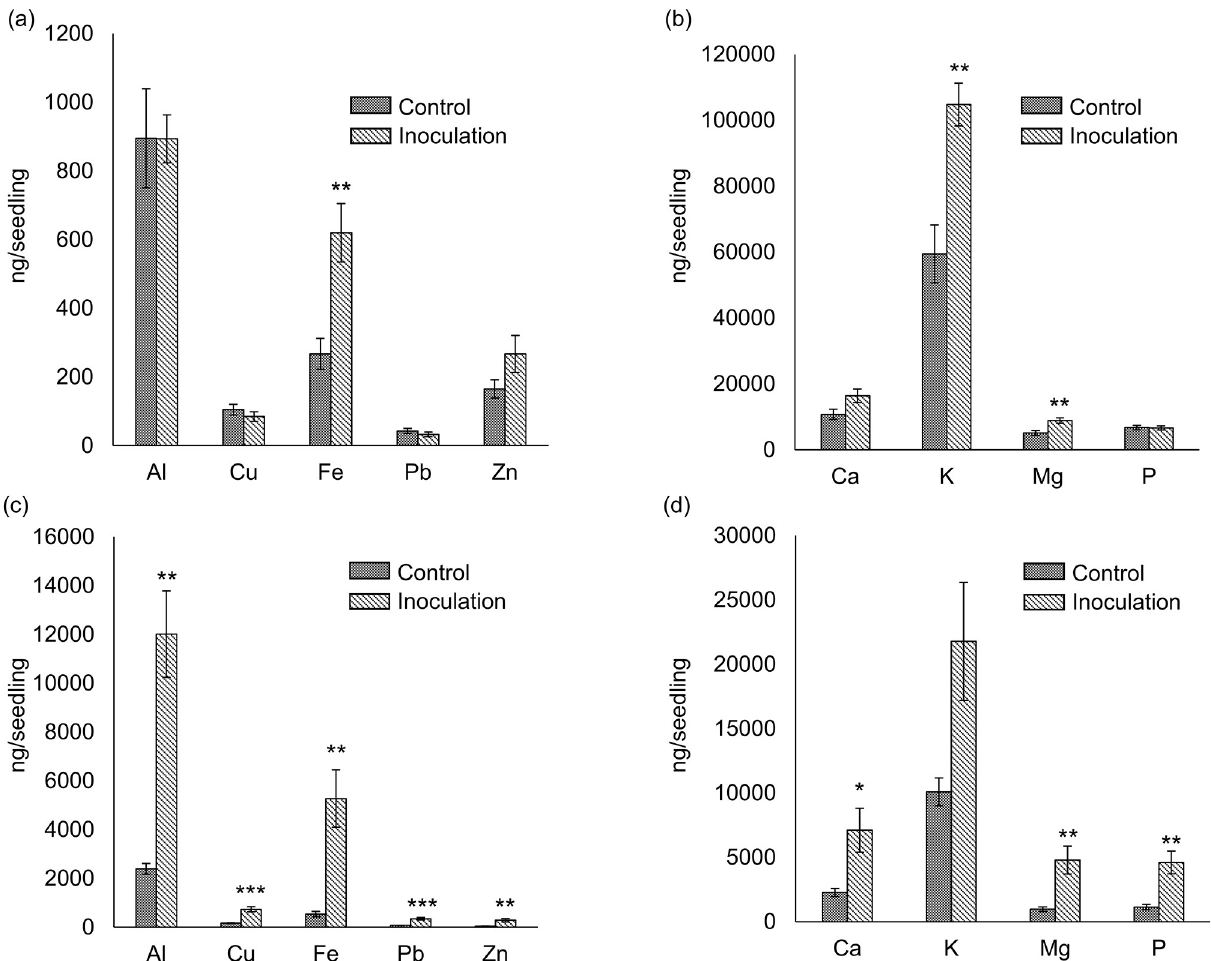
Fig 5. Amounts of elements in Miscanthus sinensis seedlings in the inoculation test. (a) Amounts of Al and heavy metals in aboveground parts of M . sinensis , and (b) amounts of inorganic elements in the aboveground parts. (c) Amounts of Al and heavy metals in M . sinensis roots, and (d) amounts of inorganic elements in the roots. Differences between seedlings inoculated with C . cupreum and control seedlings were evaluated using Student’s t -test. The results are expressed as means ± SE (n = 5). ��� , P < 0.001; �� , P < 0.01; � , P <